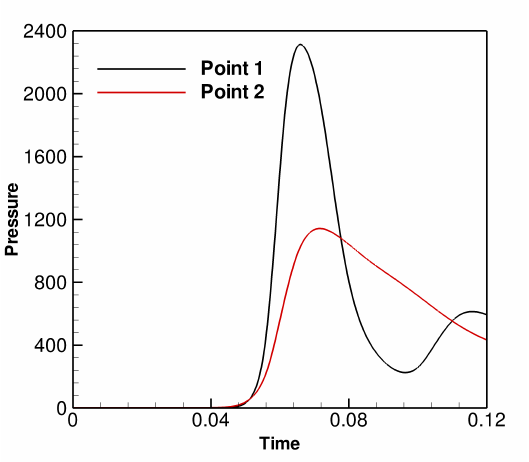
Figure 12. The pressure history recorded at the boundaries of the computational domain for an initially bullet-like bubble (Scenario